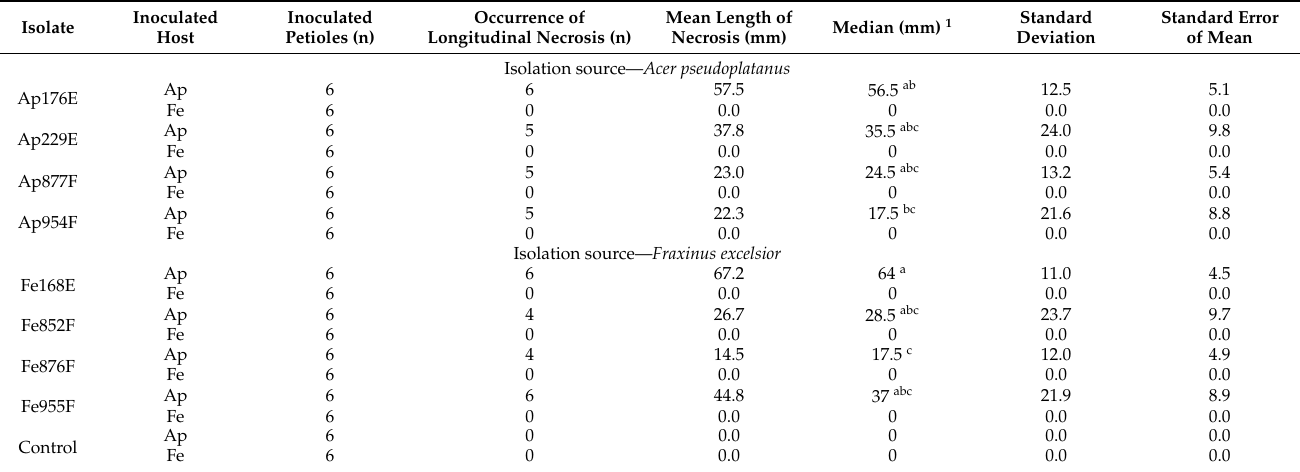
Table 4. Number of Acer pseudoplatanus (Ap) and Fraxinus excelsior (Fe) petioles with necrotic lesions and the lesion size, eight weeks post inoculation with Apiognomonia hystrix .